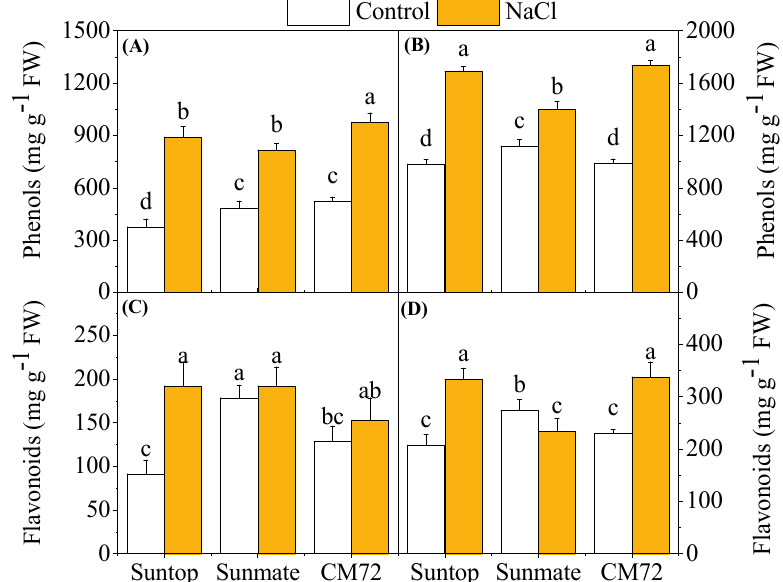
Figure 6. Total phenols content ( A , B ) and flavonoids ( C , D ) in leaves (left panel) and roots (right penal) of two wheat cultivars—Suntop, Sunmate—and barley cultivar CM72, exposed for 7 days to 100 mM of NaCl. Different letters indicate significant differences ( p ≤ 0.05) between NaCl treatment and control within the two wheat cultivars and barley cv. CM72.